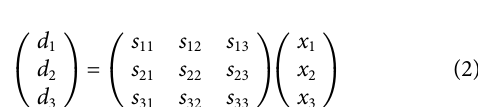
Frontiers in Earth Science |